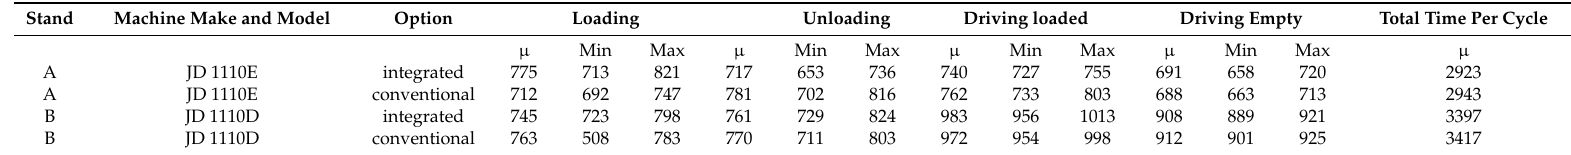
Table 4. Time consumption in the timber forwarding